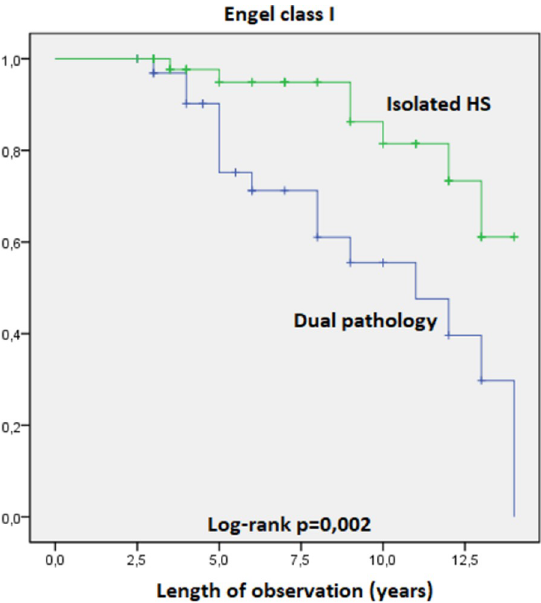
Fig 6. Kaplan-Meier survival curves of the patients in Engel class I by associated